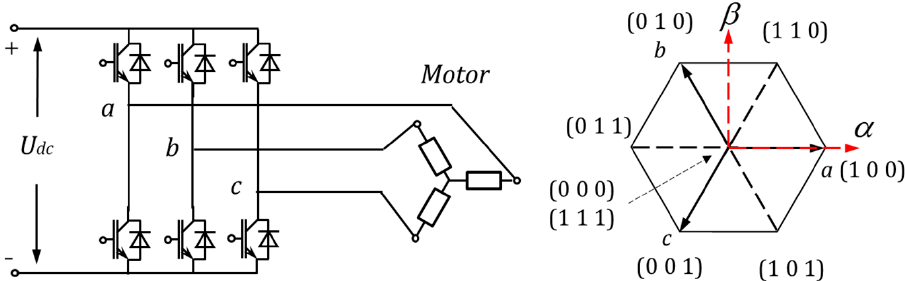
Figure 1. Three-phase inverter ( left ) and candidate voltage vectors ( right ).